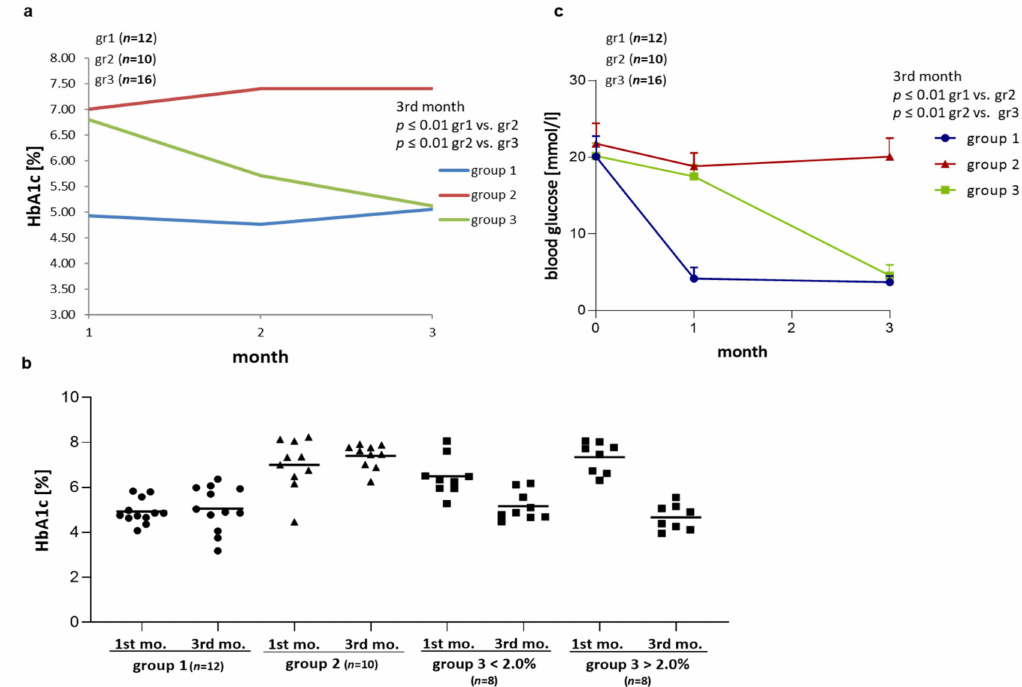
Figure 2. Effect of insulin treatment on blood glucose concentrations and hemoglobin-A1c (HbA1c) levels. ( a ) HbA1c values over time in the three groups of BB/OKL rats (mean HbA1c values ± SD are given in Table 2). ( b ) Dot plot represents HbA1c values at the end of month 1 and 3 in all experimental groups. Group 3 has been stratified by decrease in hemoglobin-A1c. ( c ) Blood glucose concentration (mean values ± SD are given in Table 1). A blood glucose concentration of ≥ 16 mmol/L in BB/OKL rats was a criterion to include the animals in the studies. Note that 2U of insulin treatment in group 1 ( n = 12) and in group 3 animals ( n = 16; after 2nd month) significantly decreased blood glucose and HbA1c levels compared with 1U of insulin treated animals of group 2 ( n =